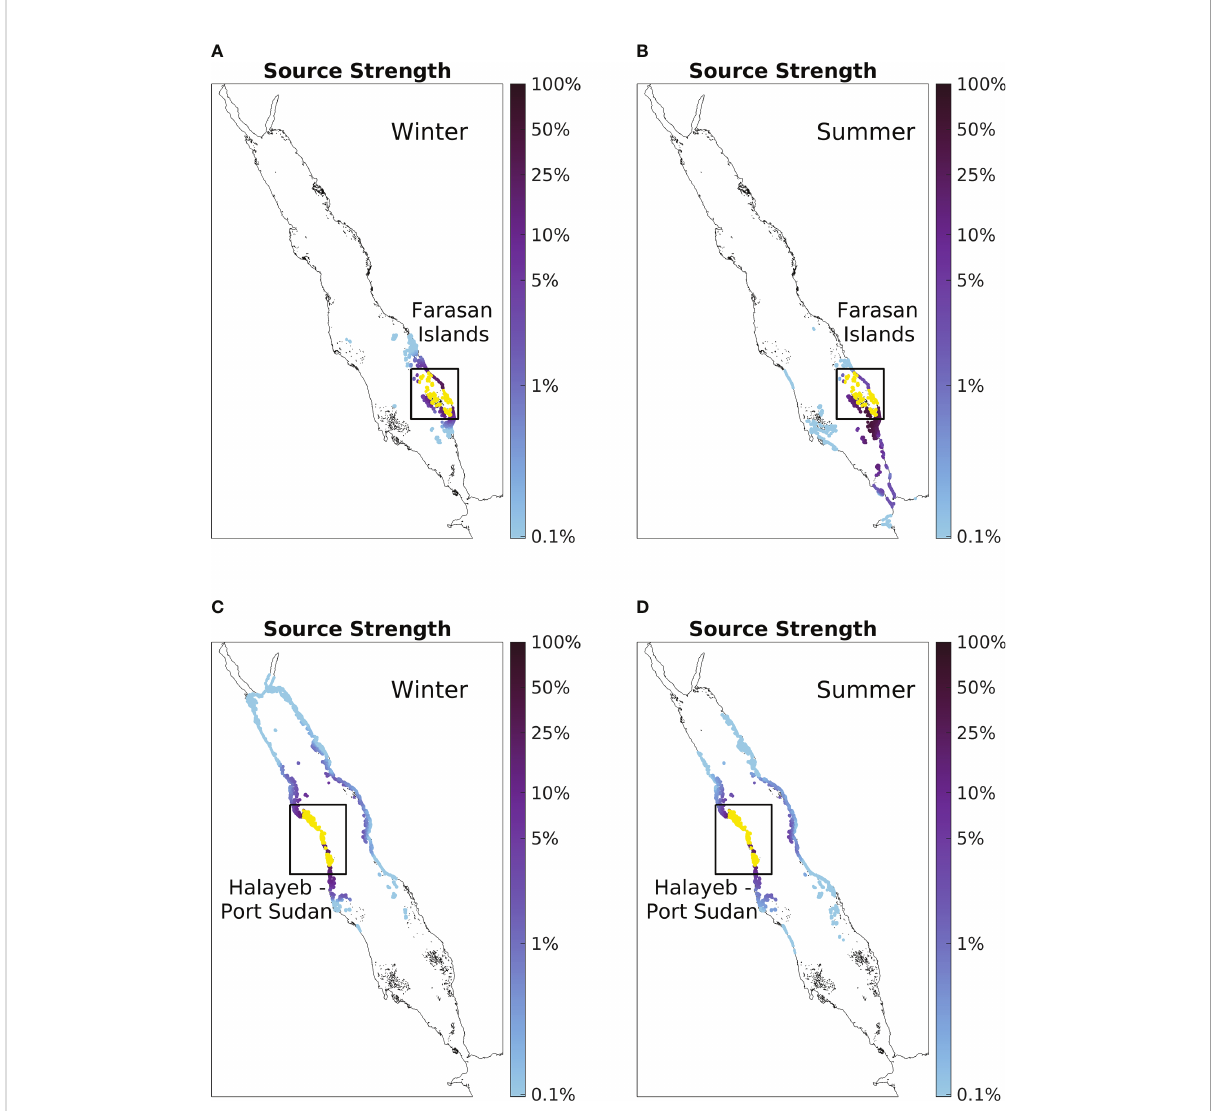
FIGURE 5 Case studies of in fl uencing strength seasonality. (A) Winter source strength of Farasan Island. Values are calculated based on simulations conducted during winter with particles being released in January and tracked for 30 days. (B) Summer source strength of Farasan Island with particles being released during summer (in July). Panel (C, D) are the same as Panel (A, B) , but for the coastline between Halayeb and Port Sudan instead. Note the logarithmic scale of the